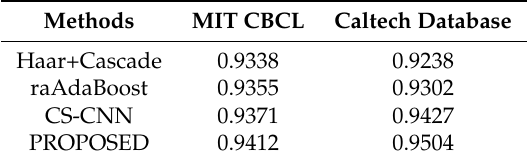
Table 3. Comparison between the accuracy of our proposed method and other methods.